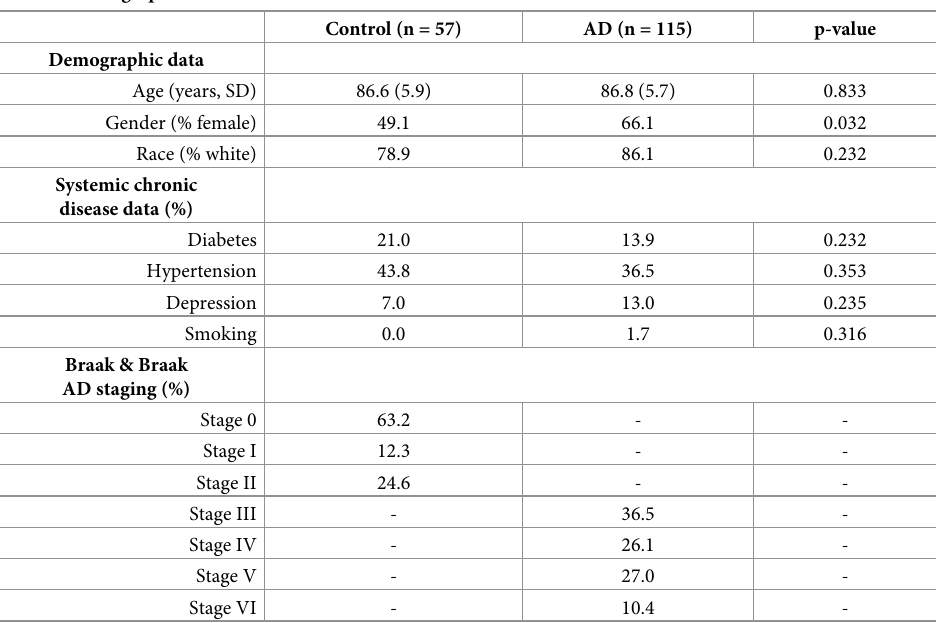
Table 1. Demographic characteristics of the cohort.